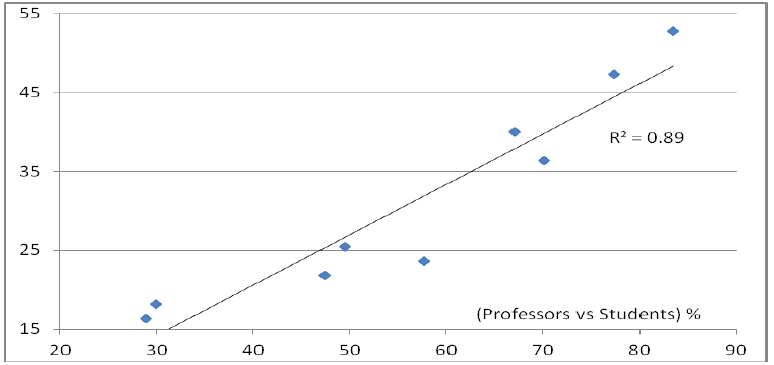
Figure 1. Comparing breakdown percentage between obstacles identified by university teachers and students. Table 7. Summary output regression statistics analysis comparing breakdown between obstacles identified by university teachers and